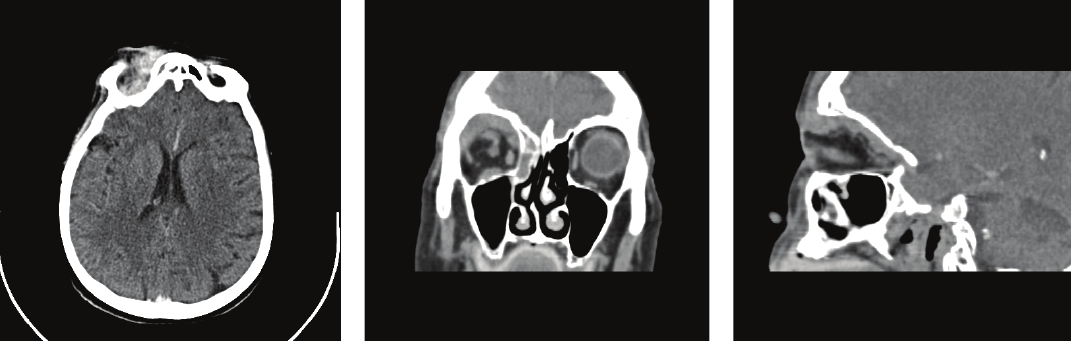
Figure 1: Triplanar views of a noncontrast CT scan showing opacification of the right ethmoidal and frontal sinuses with medial orbital